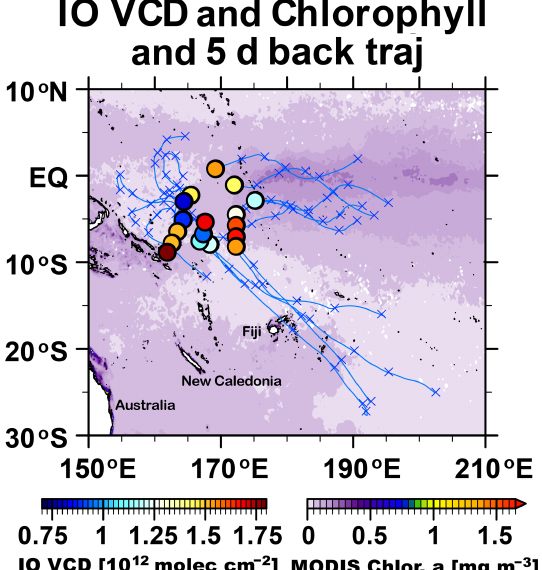
Figure 5. Daily median tropospheric IO vertical column densities (VCDs; molec.cm − 2 ) observed from R/V Mirai during 16 Novem- ber to 2 December 2014 and chlorophyll a concentrations observed via satellite (MODIS). Blue crosses and lines represent 5d back- ward trajectories.